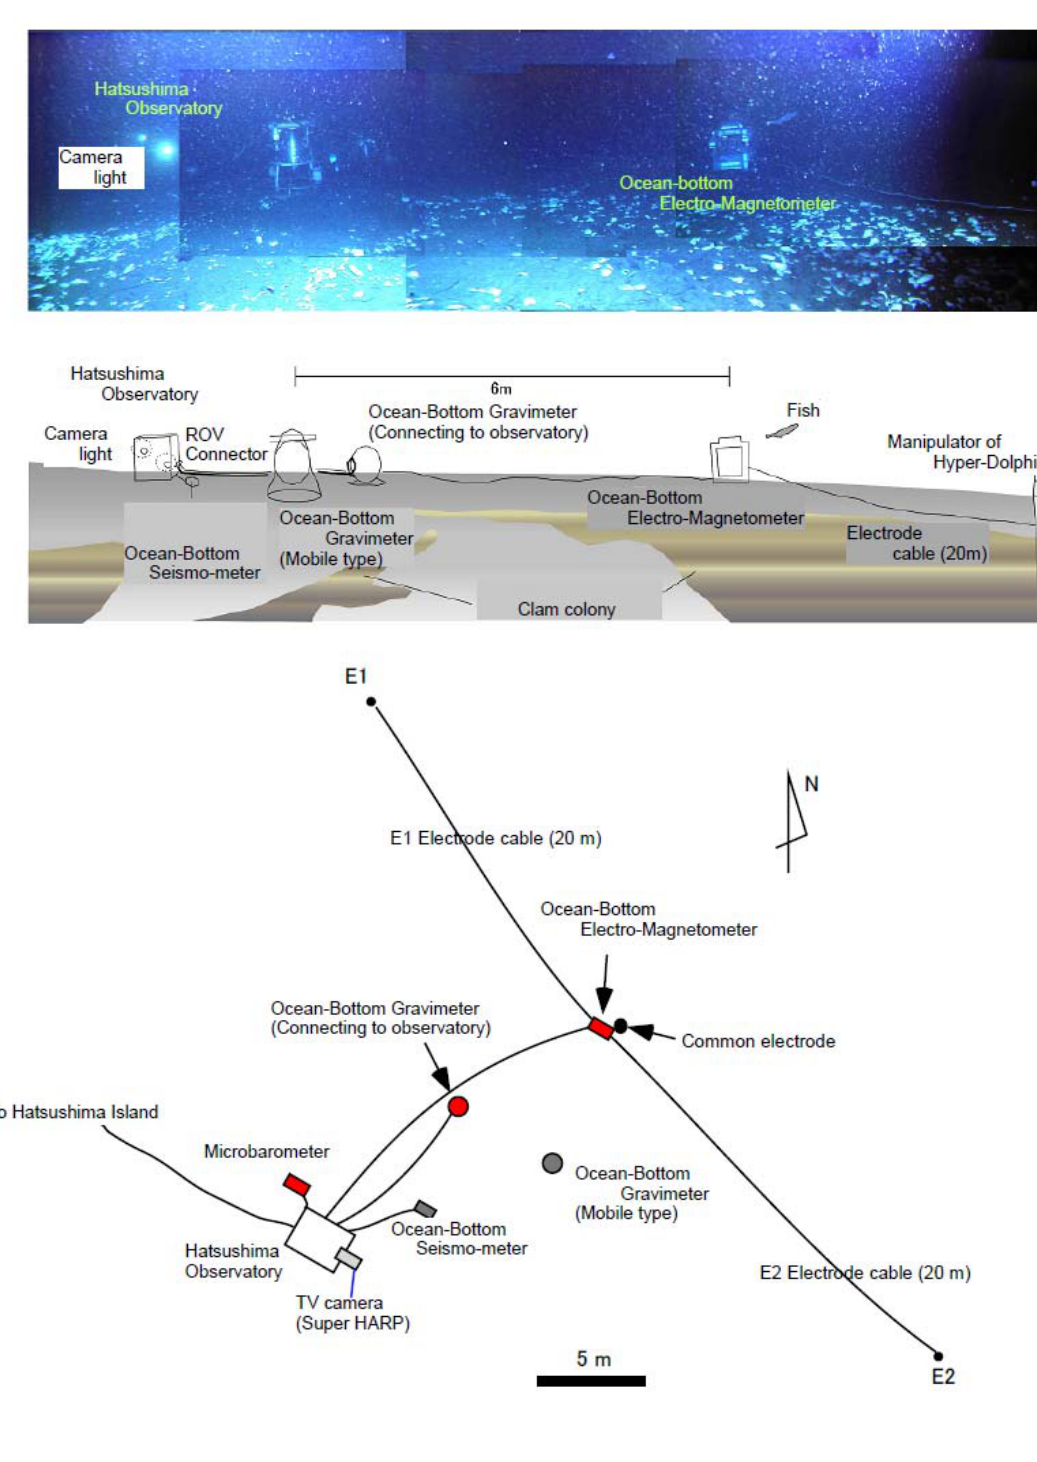
Figure 3. (Upper panel) Photograph and arrangement map of various instruments. (Lower panel) Plain view around the Hatsushima Observatory. Red marks show instruments placed by